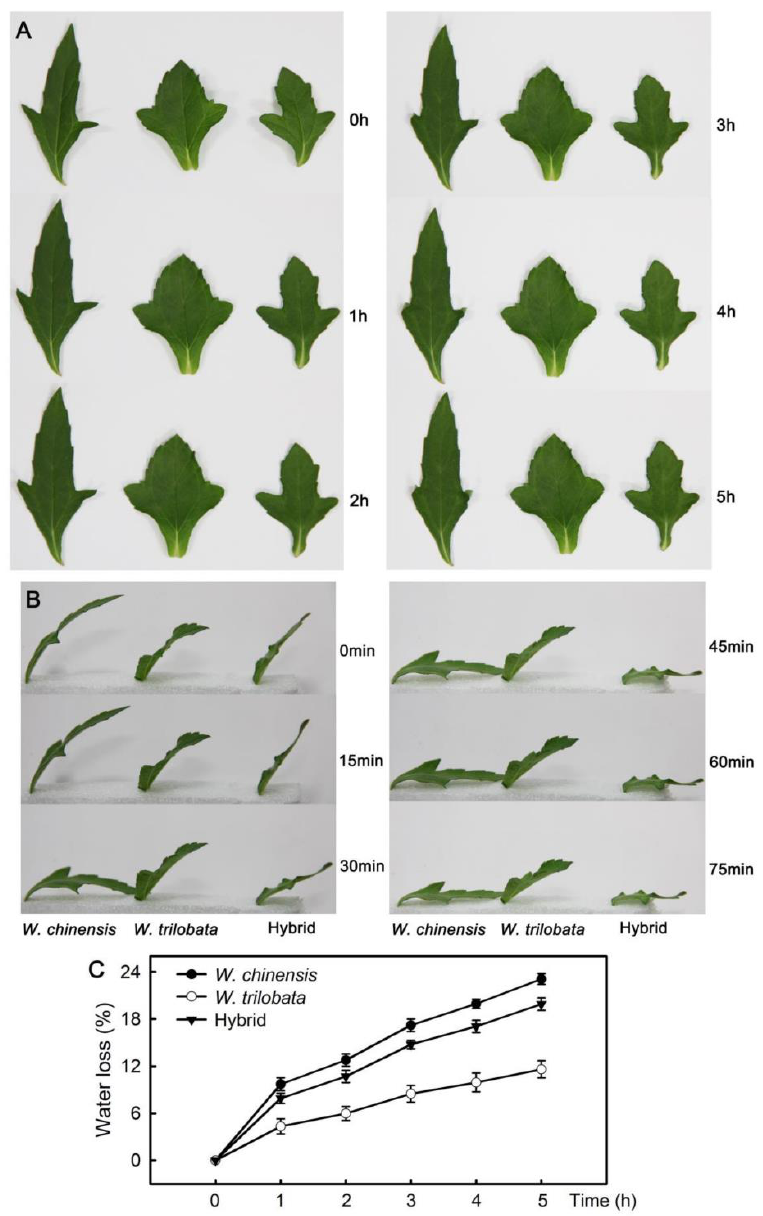
Figure 1. Phenotype and water loss. Phenotypic changes of detached leaves ( A , B ). Comparison of the water loss rate of Wedelia chinensis , Wedelia trilobata , and their hybrid of detached leaves ( C ). The data are shown as means ± standard errors (SE), and the study included five biological replicates.